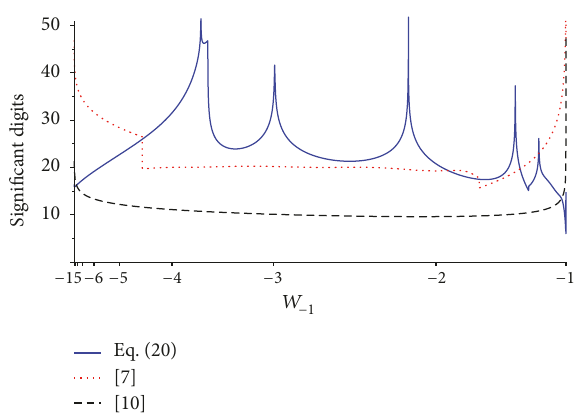
Figure 2: Significant digits for (20) and the ones reported at [7, 10] after a single pass of iterative scheme of (30).